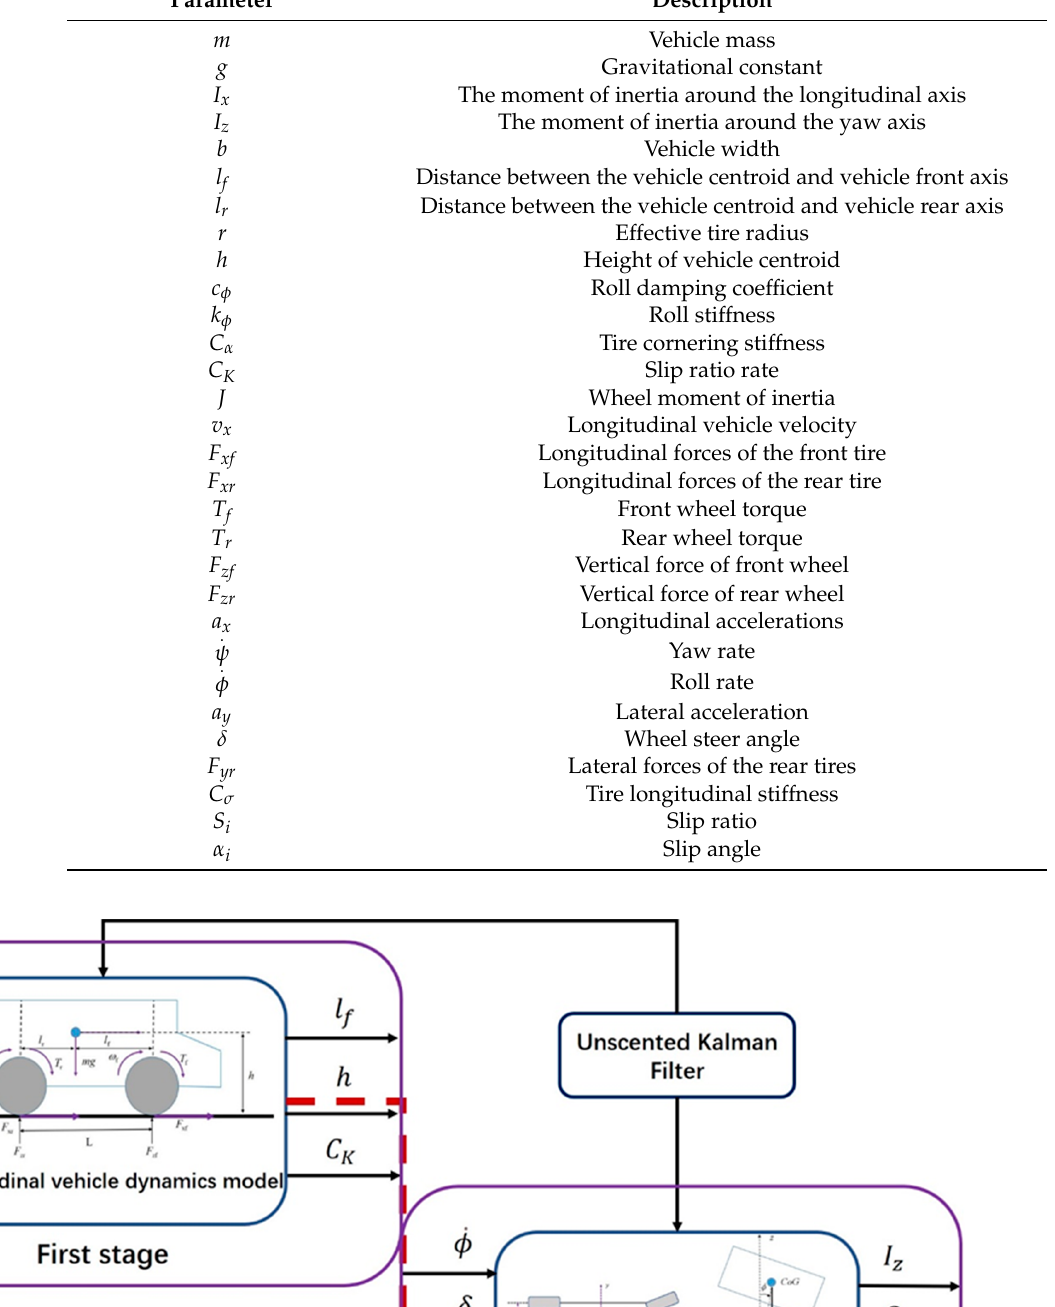
Table 1. Nomenclature.